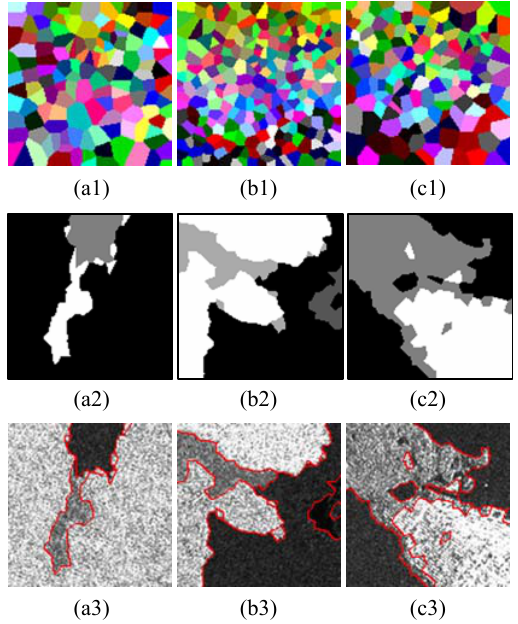
Figure 5. Visual evaluation of real SAR images, (a1)-(c1) Voronoi (a2)-(c2) segmentation results, and (a3)-(c3) overlaying the extracted outlines on the original images.